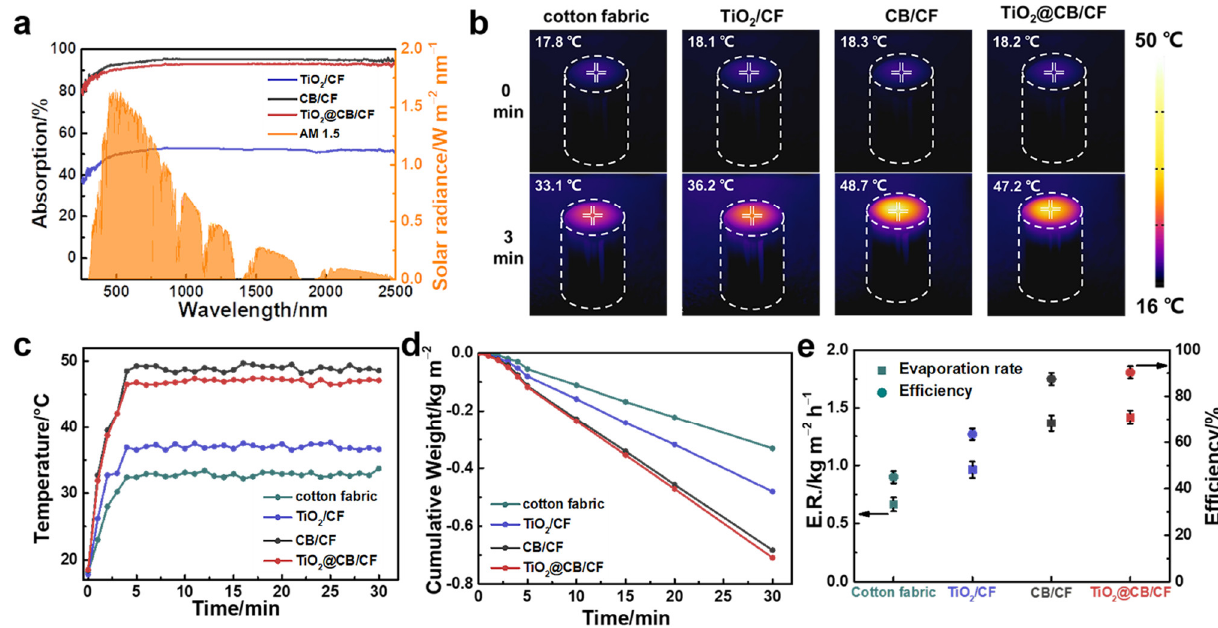
Figure 3. The photothermal conversion performance of the TiO 2 @CB/CF evaporator and control sample. ( a ) The light absorption curves of TiO 2 /CF, CB/CF, and TiO 2 @CB/CF. ( b ) The surface temperature of the TiO 2 @CB/CF evaporator and control sample before and after one-sun illumination by IR thermal images; ( c ) temperature evolution, ( d ) cumulative weight change, ( e ) evaporation rate evolution and energy conversion efficiency of the TiO 2 @CB/CF evaporator and control sample under 1 kW m -2